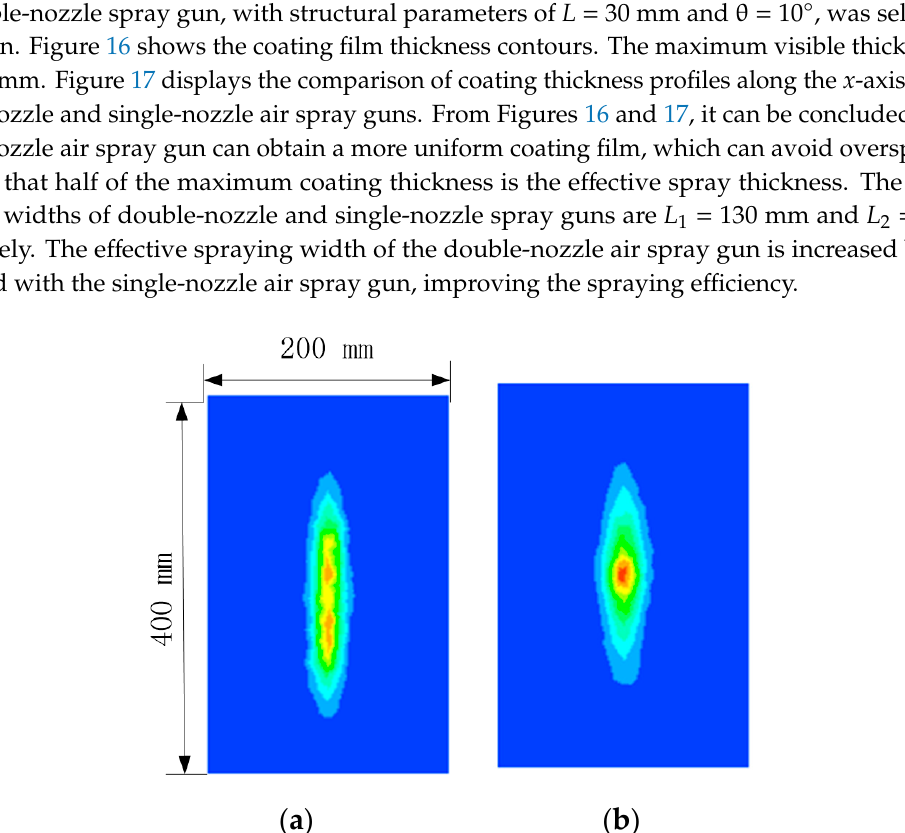
Figure 15. Coating thickness profiles along the x- axis for different L values when θ = 10°.